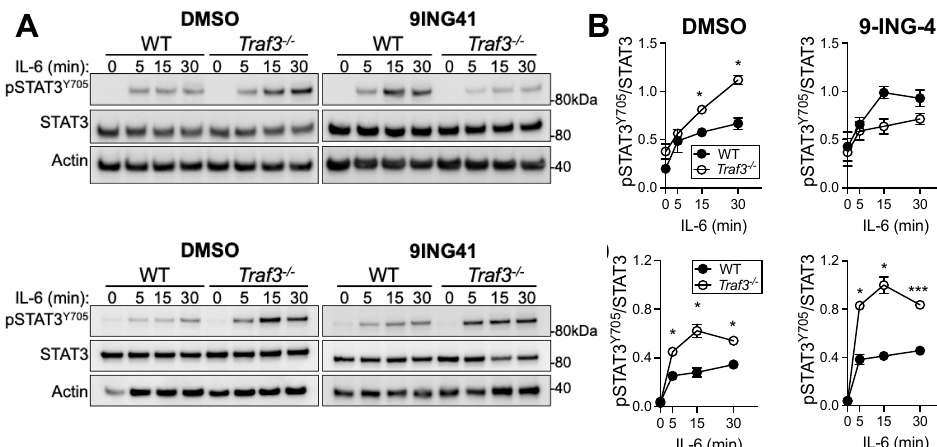
Figure 4. Differential effect of GSK3 inhibition on IL-6-induced STAT3 activation. ( A ) Representative Western blot of IL-6-induced pSTAT3 Y705 in 9-ING-41 or DMSO-treated mouse BCL cells (A20.2J and Traf3 − / − A20.2J). ( B ) Quantification of 4 replicates including A. ( C ) Representative Western blot of IL-6-induced pSTAT3 Y705 in 9-ING-41 or DMSO-treated primary WT or Traf3 − / − mouse B cells. ( D ) Quantification of 3 replicates including C. Data points are mean ±SEM. *** p < 0.001, * p < 0.05 by repeated-measures ANOVA with Sidak’s multiple comparisons test. Uncropped blots and densitometry shown in Figures S6 and S7.